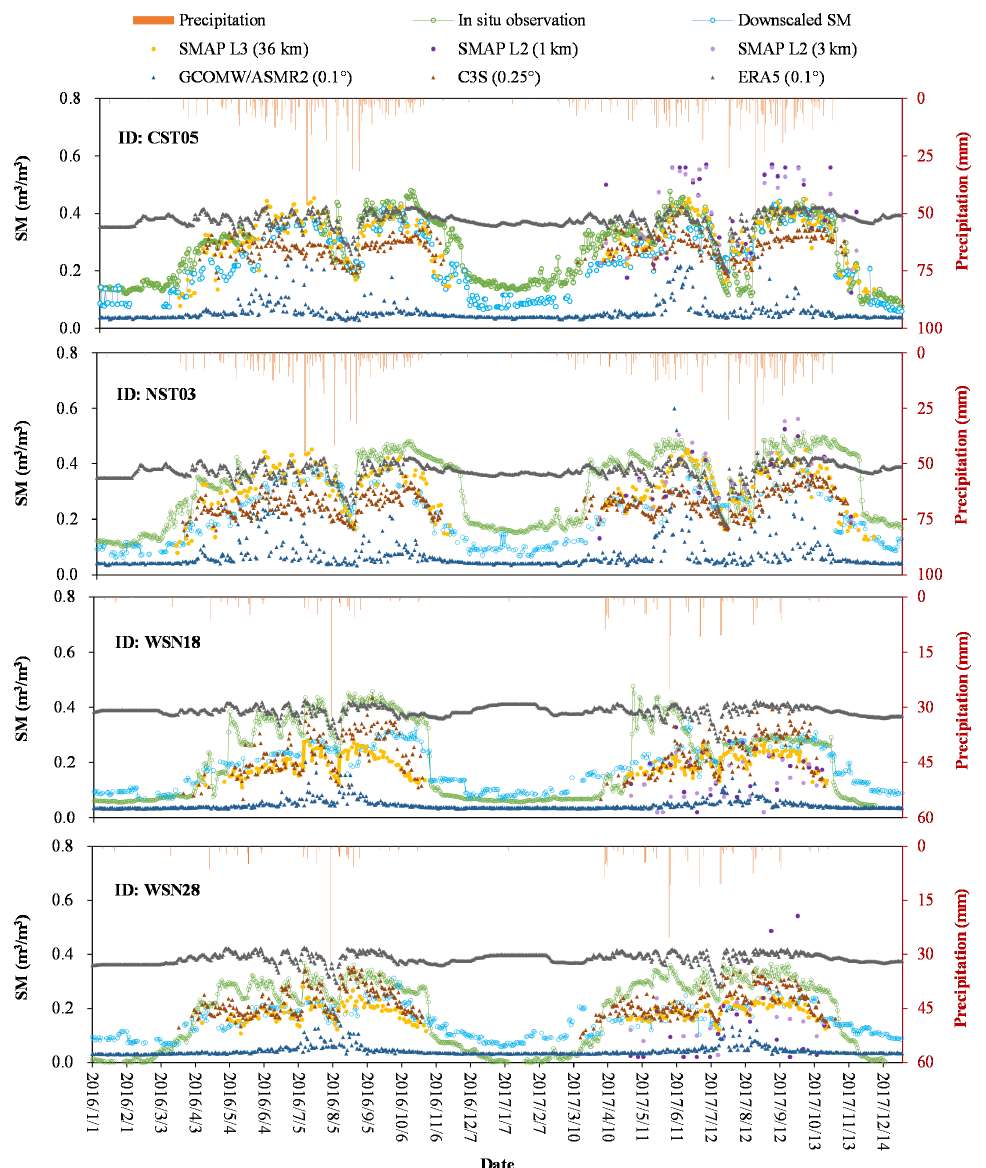
Figure 9. Time series of the in situ observed SM, the downscaled SM, the acquired gridded SM products and daily precipitation at the four selected SM sites (from Maqu network and Babao network, respectively) in